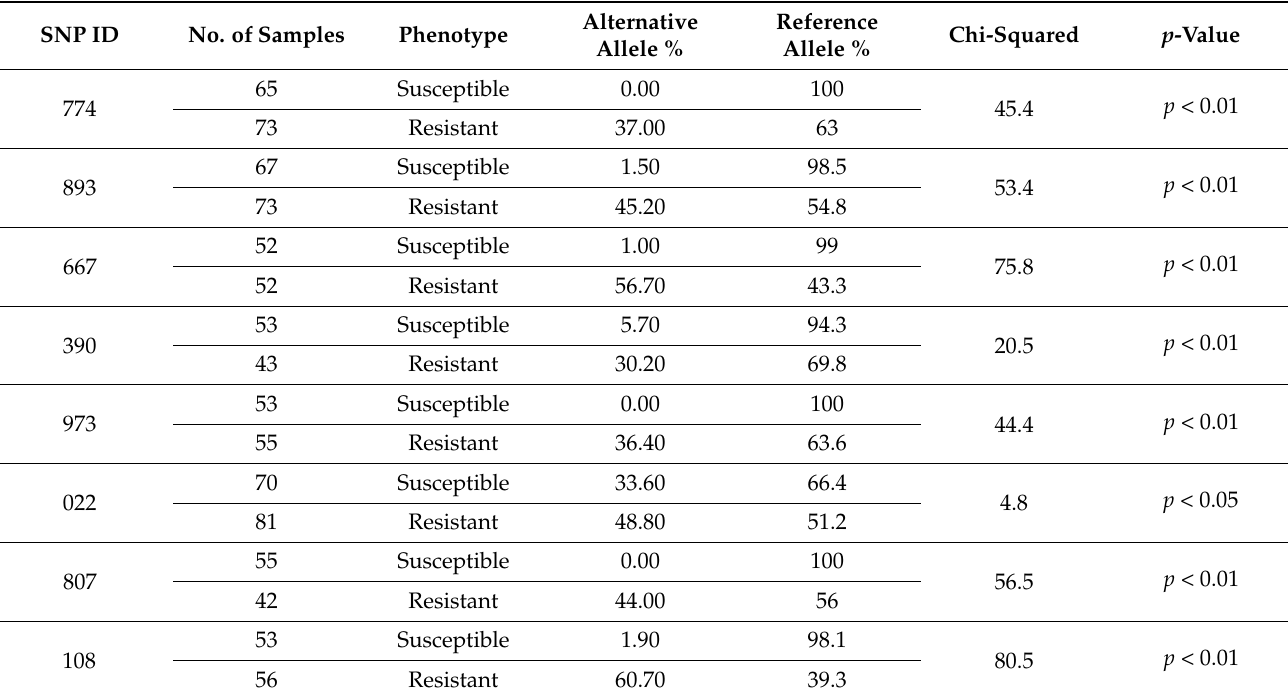
Table 1. Allele frequency distribution of validated SNP targets by rhAmp